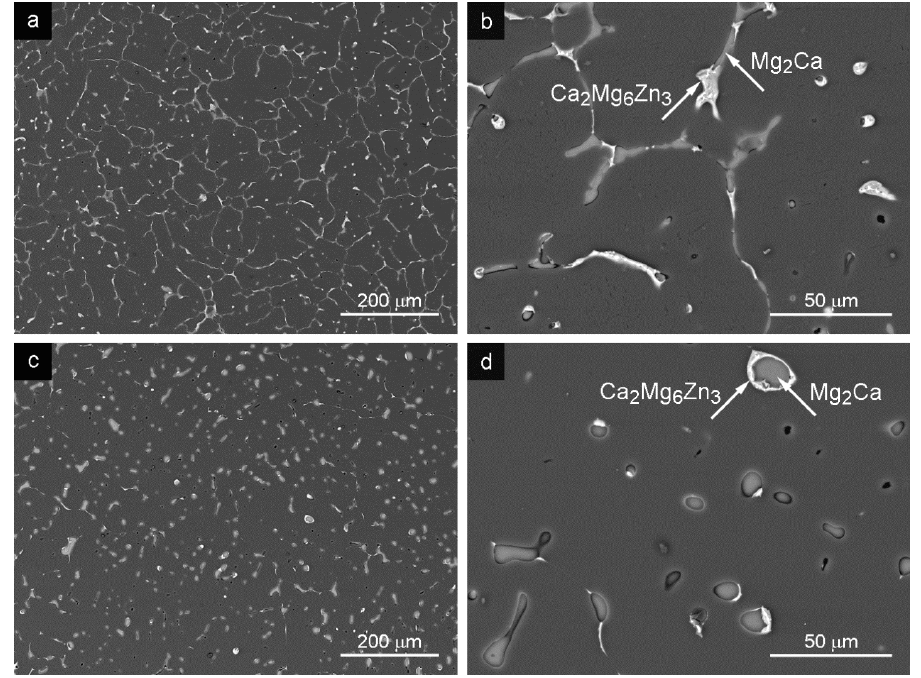
Figure 1. Microstructure of the GC alloy: ( a ) as-cast; ( b ) secondary phases in the as-cast state; ( c ) GC + HT; ( d ) secondary phases in GC + HT state depicted in the SEM–BSE mode. Table 1. Average grain size of the alloy processed by various methods.